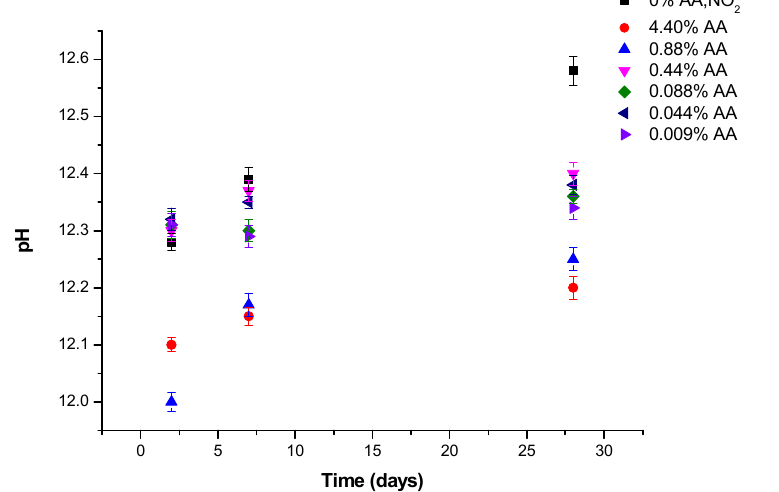
Figure 11. pH of cement pastes with different amounts of AA determined by ESL